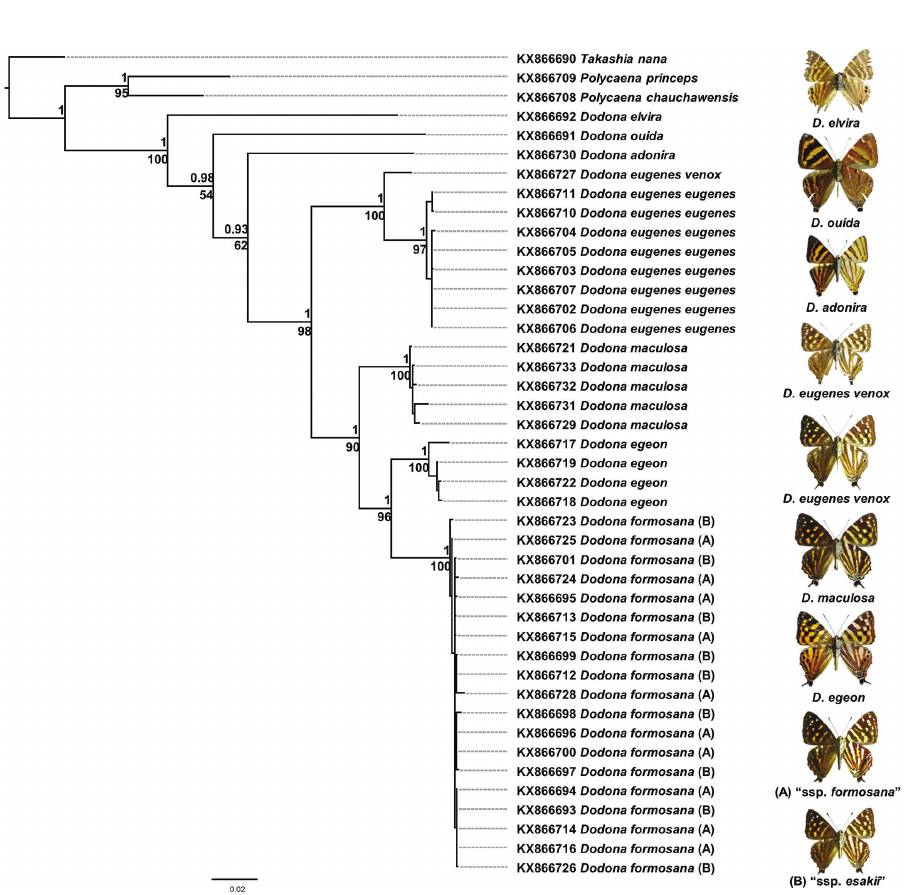
Figure 3. Phylogenetic relationships of sampled Dodona butterflies based on BI method. Posterior prob- abilities are showed above branches and ML bootstrap values are below. A ssp. formosana B spp. esakii .